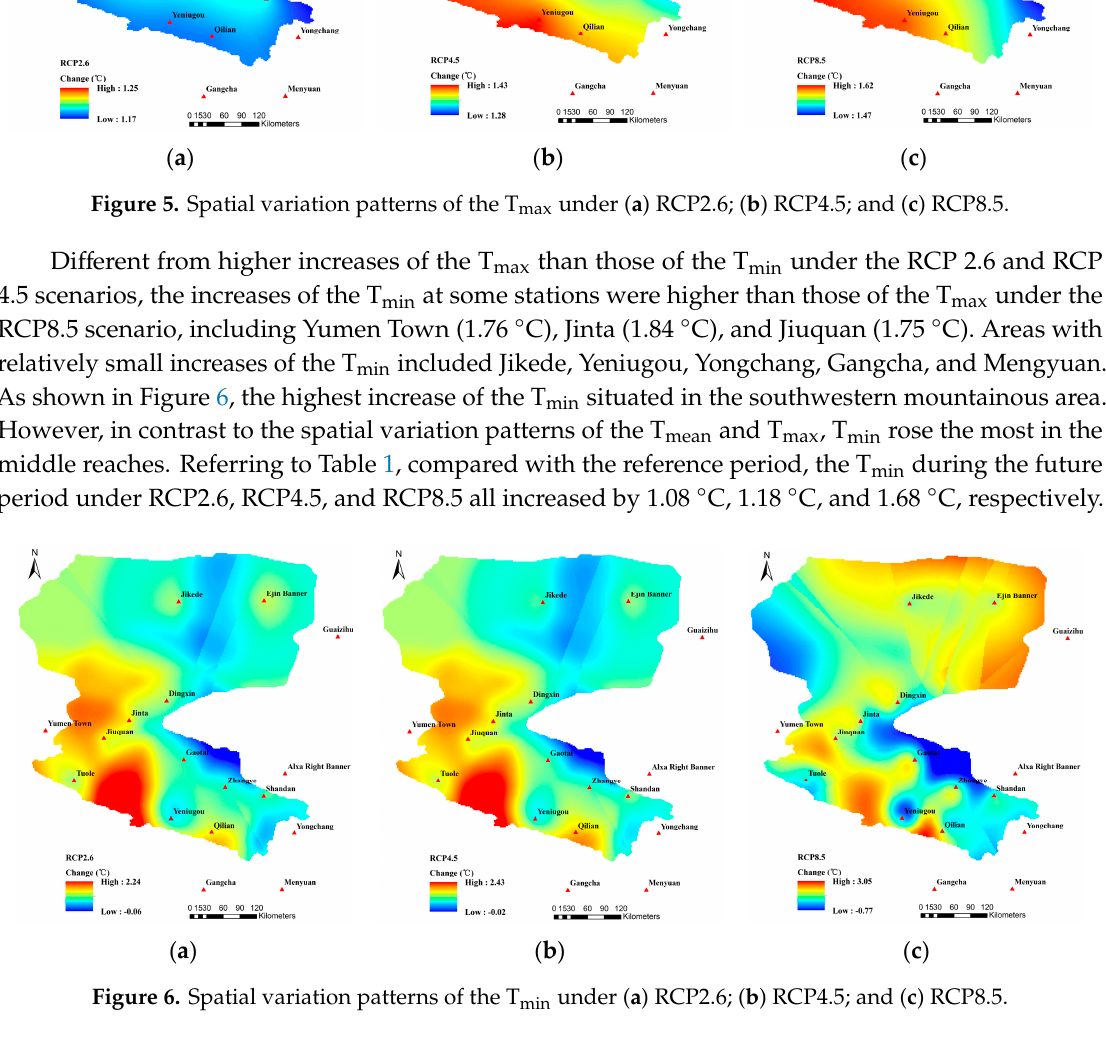
Figure 5. Spatial variation patterns of the T max under ( a ) RCP2.6; ( b ) RCP4.5; and ( c ) RCP8.5.